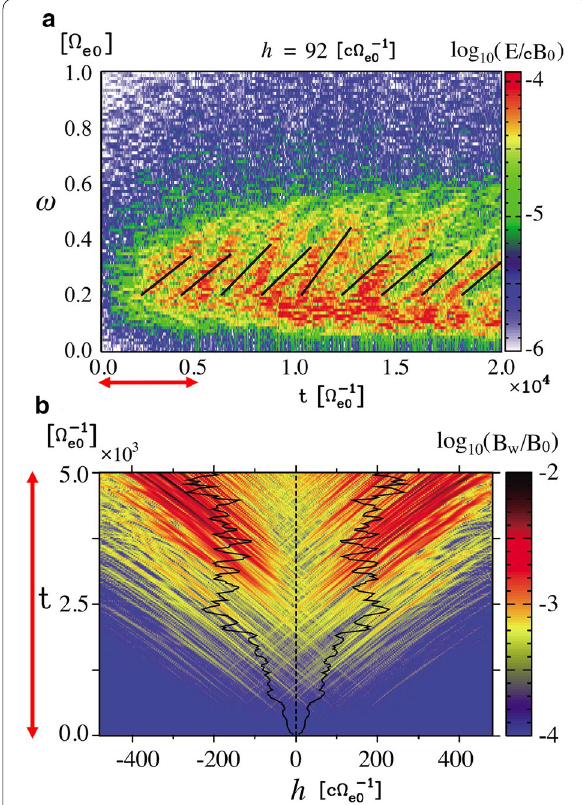
Fig. 5 Chorus simulation. Electron hybrid simulation of whistler-mode chorus emissions. a Dynamics spectra of transverse electric field. b Spatial and temporal evolution of wave amplitudes B w of chorus emissions in the early period of the simulation run indicated by red arrows. Solid lines show location of the critical h c ( t ) from the equator, where h c ( t ) is evaluated from the distance ± 10 10 c (cid:31) − 1 e0 (after wave amplitude B w ( h , t ) averaged over h = − ∼ Katoh and Omura